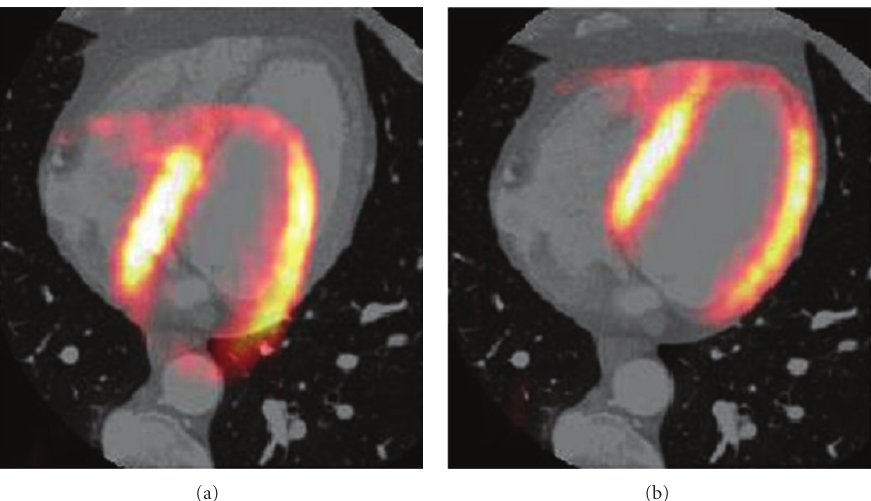
Figure 6: Example of misaligned (a) and aligned (b) transaxial PET and CT images corresponding to dataset 1.